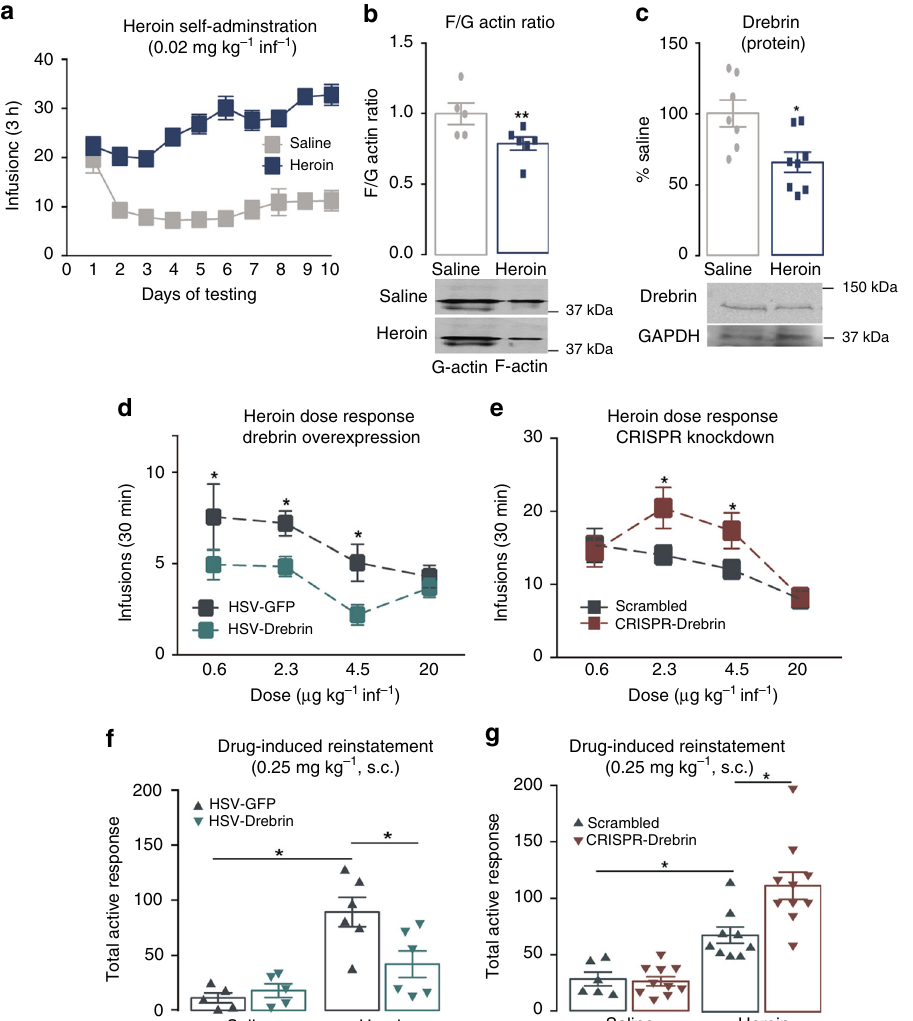
Fig. 1 Drebrin mediates behavioral plasticity in the NAc. a Mean numbers of infusions of saline (gray) or heroin (blue) self-administered over 10 days (two- way repeated-measures ANOVA: drug effect, F 1,41 = 76.74, P < 0.001; day effect, F 9,369 = 7.899, P < 0.001; interaction, F 9,369 = 8.882, P < 0.001, n = 19 – 24 per group). Actin cycling (Student ’ s t -test: t 9 = 2.632, P = 0.027, n = 6 – 7 per group) ( b ) and drebri n protein levels (Student ’ s t -test : t 13 = 2.953, P = 0.011, n